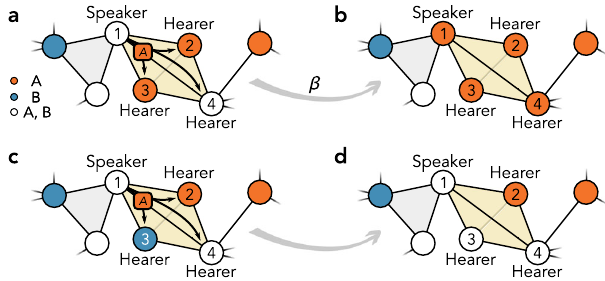
Fig. 1 Dynamics of the model. Agents are represented by the nodes of a social structure composed by interacting groups of different sizes. The vocabulary of the agents--for simplicity containing at most only two names (or conventions) { A , B }--is re fl ected in the colours of the nodes as shown in the legend. At each interaction, a group is chosen at random (highlighted in yellow in the fi gure) together with a speaker (node 1), while the remaining nodes act as hearers. Here we illustrate the unanimity rule (see model de fi nition). a The speaker chooses a name at random from its vocabulary (here, A ), and communicates it to the rest of the group. Since A is present in the vocabularies of all the hearers (nodes 2 and 3 support A , while node 4 knows both names), the group can reach an agreement. b With probability β the group agrees on the chosen name, and all nodes involved immediately update their vocabulary to A , erasing B . With probability 1 − β instead the agreement does not happen. c In this case, the speaker selects A , but node 3 does not possess A in its vocabulary. d Thus, there cannot